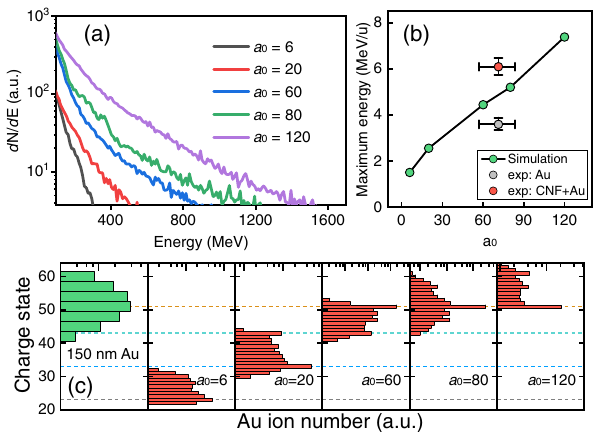
FIG. 8. (a) Energy spectra of Au ions at different intensities controlled by changing the pulse duration while keeping the laser energy constant. (b) Dependence of the maximum Au ion energy on laser intensity. Symbols with error bars mark the experimental results. (c) Charge-state distributions of Au ions in experiments (green bars) and PIC simulations (red